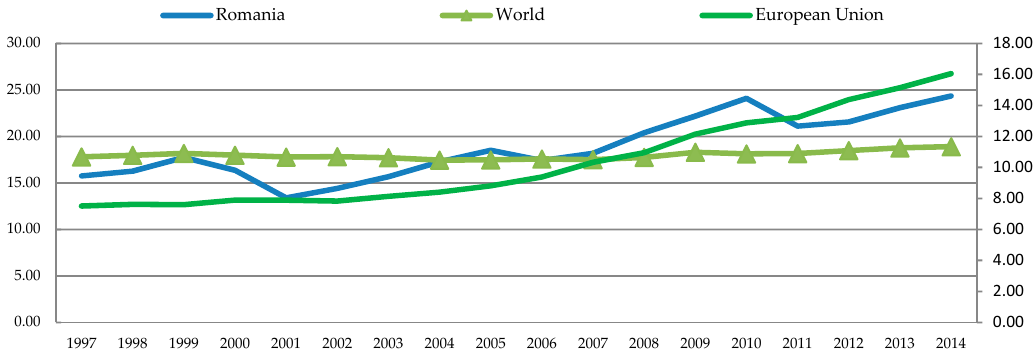
Figure 9. Renewable energy consumption (% of total final energy consumption), Source: Own representation based on World Bank data [24].